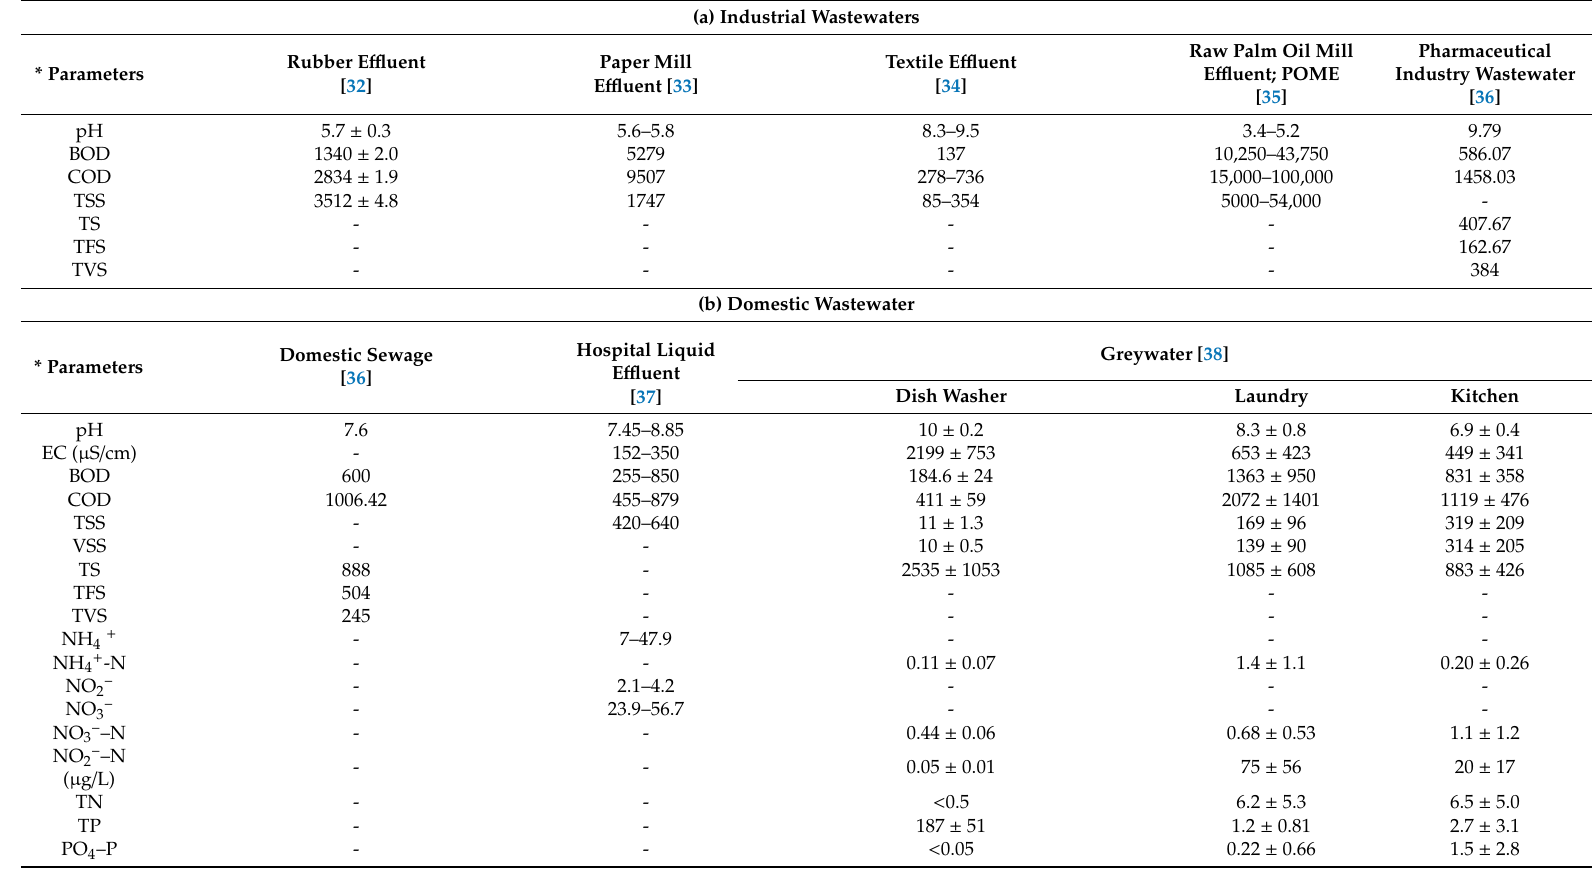
Table 2. Physicochemical properties of various industrial e ffl uents and polluting